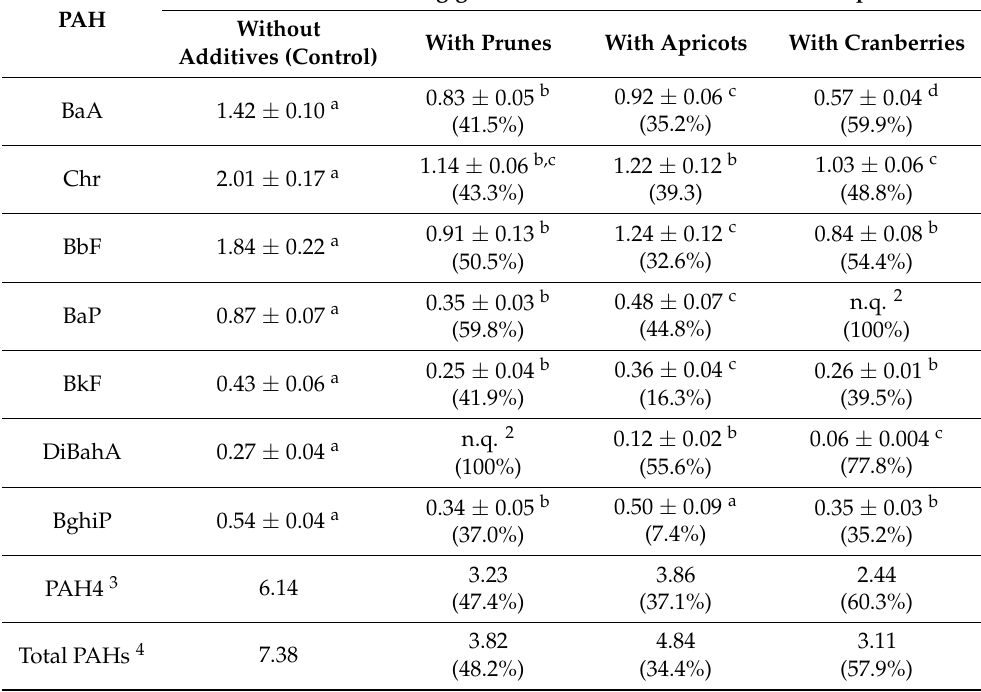
Table 4. PAH concentration (ng/g of meat) and the inhibitory effect (%) of dried fruits on PAH content in pork meat roasted with and without additives. The results are presented as means ± standard deviations (SD). They correspond to two HPLC analyses of the fractions obtained from three repeated extractions of each meat sample (n = 6). Different letters (a, b, c, d) in each row indicate statistically significant differences ( p <